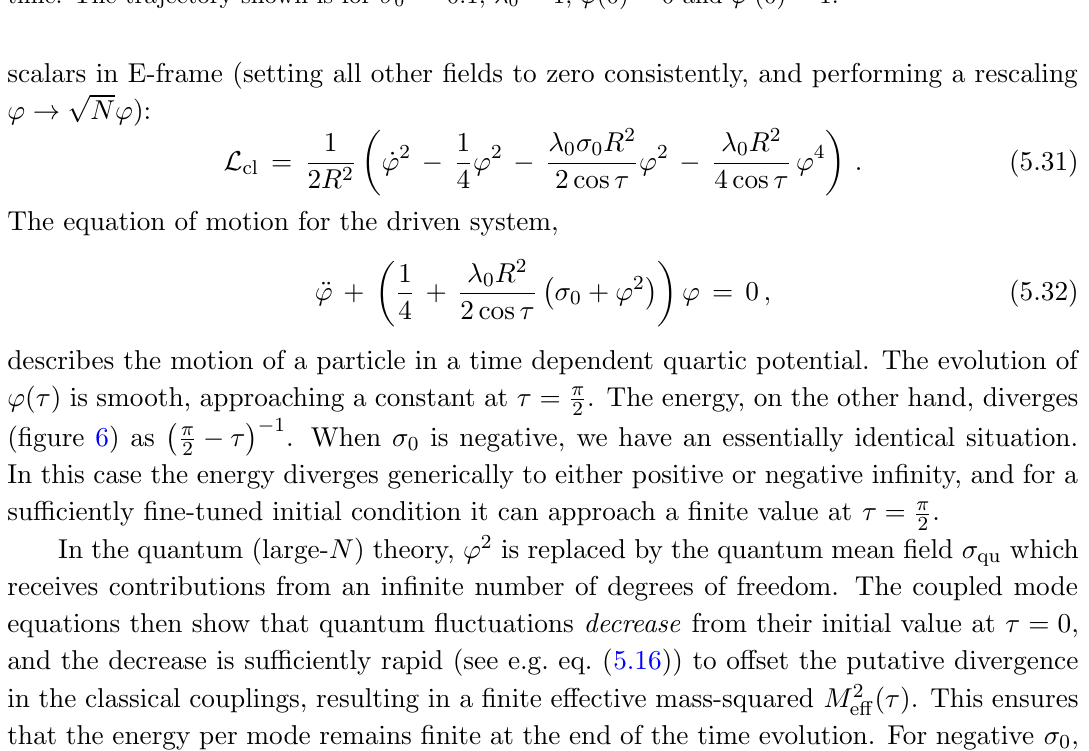
Figure 6 . The classical (cid:12)eld evolves smoothly towards (cid:28) = (cid:25) time. The trajectory shown is for (cid:27) 0 = 0 : 1, (cid:21) 0 = 1, ’ (0) = 0 and ’ 0 (0) = 1.